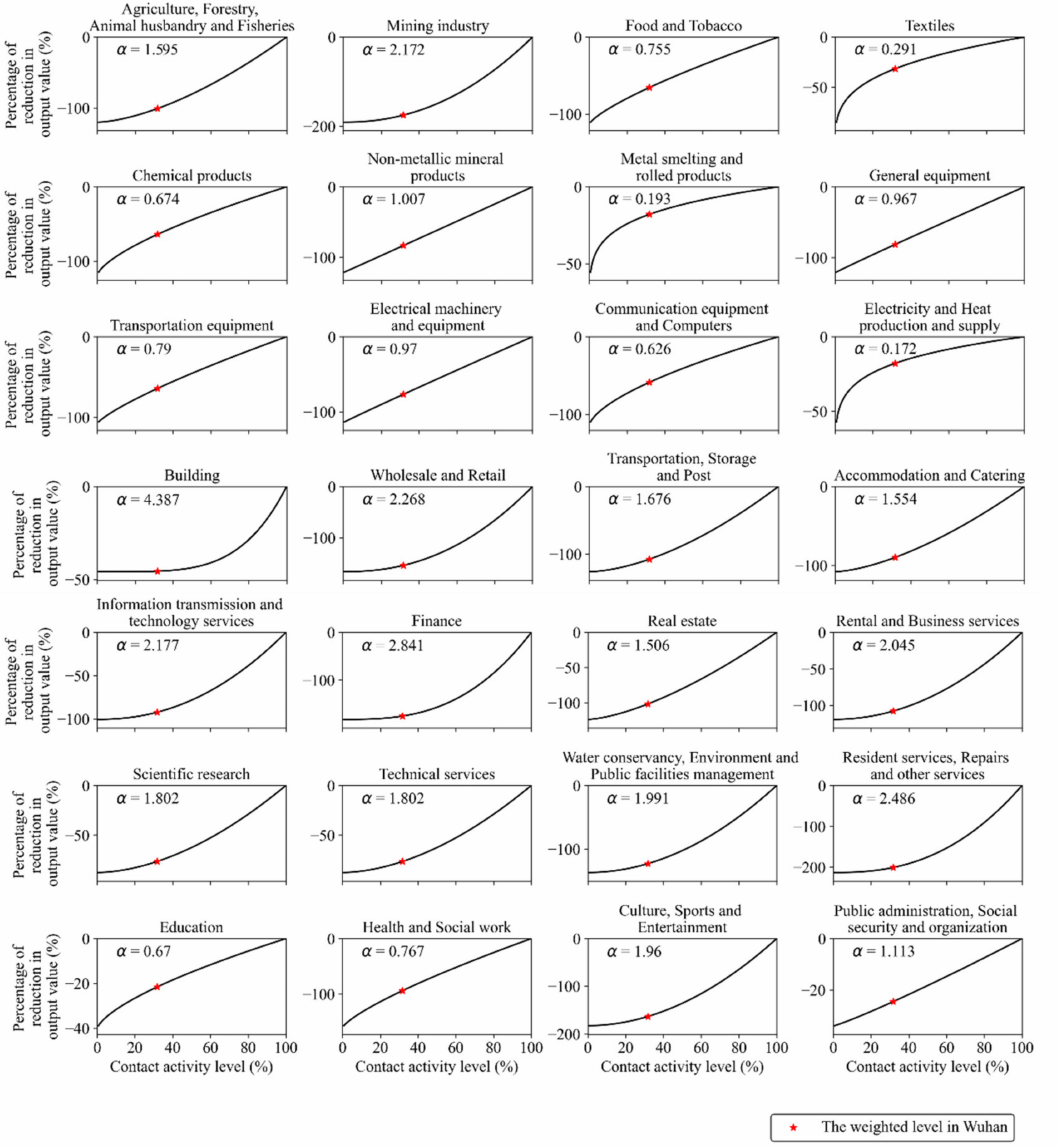
Figure 5. Reduction percentage of each industry sector under the different level of contact activity in Wuhan. The weighted level in Wuhan is the reduction in contact activity caused by the COVID-19 outbreak in Wuhan Equations (5) and (6)); α is the degree of nonlinearity of each industry sector’s response to the reduction in contact activity (cid:16) (cid:17) r (see Equation (8)). When the contact activity level reaches 100% ( r = r 0 ≈ 13.96), it means returning to the level before r 0 the COVID-19 outbreak in